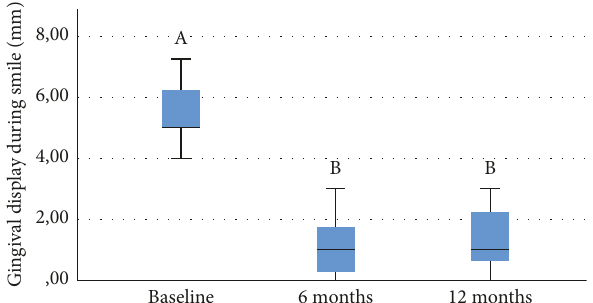
Figure 9: Mean of gingival display along the periods